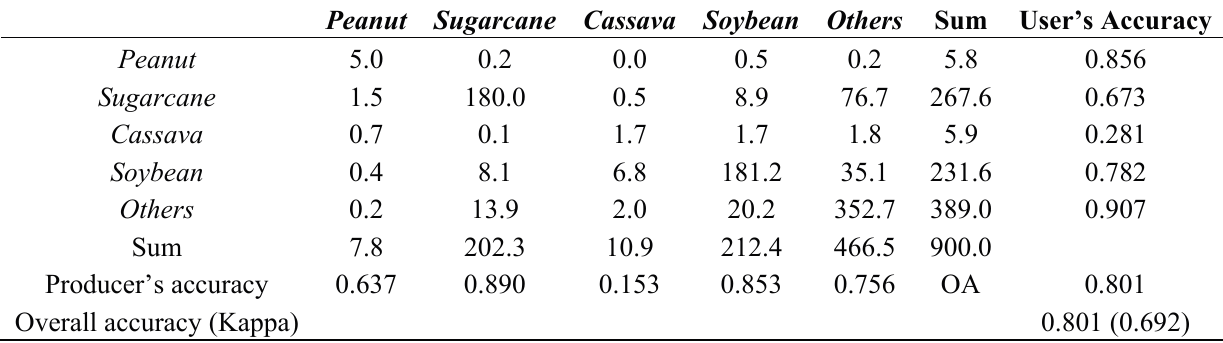
Table 10. Confusion matrix obtained by selecting the best mapping parameter set from results obtained for the four test sites. The values reported in the matrix are given in km² and refer to the four test sites (sample